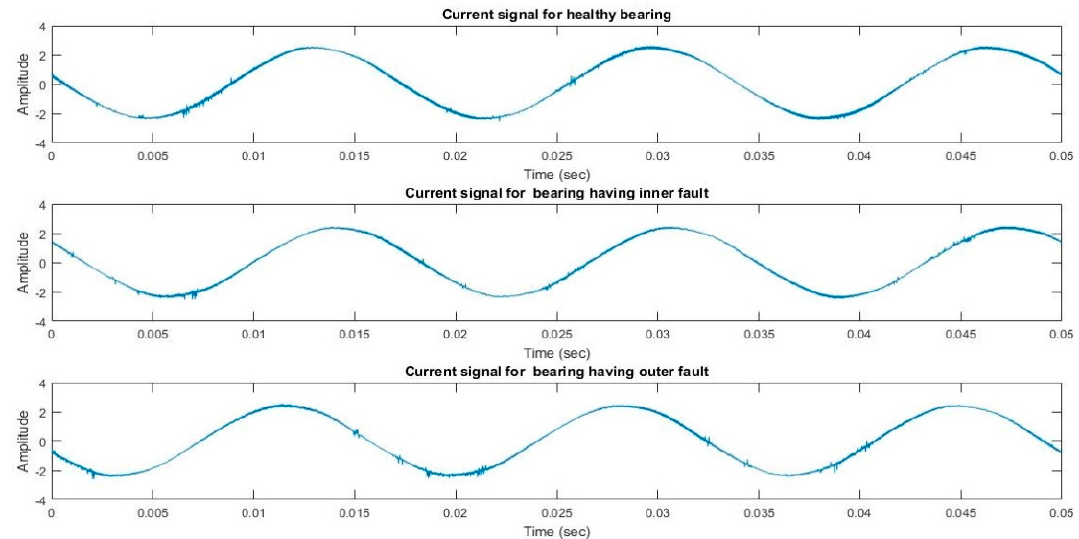
Figure 3. Motor current signal for three different conditions of bearing mentioned in Table 2.